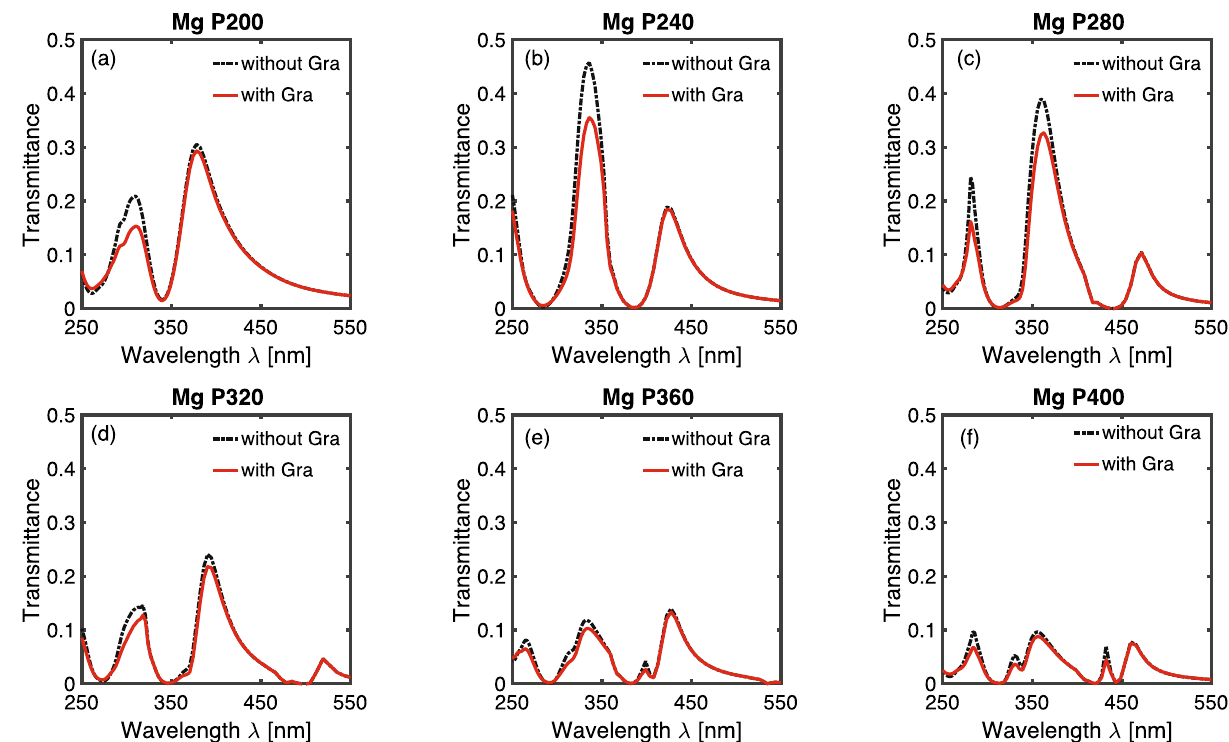
Figure 4. Transmission spectrum of a magnesium hole-array with and without a single-layer intrinsic graphene. The periodicities of the magnesium hole-arrays are ( a ) 200 nm ( b ) 240 nm ( c ) 280 nm ( d ) 320 nm ( e ) 360 nm ( f ) 400 nm. The dashed black curve represents the spectrum for a magnesium hole-array without graphene layer; the solid red line represents the spectrum for a magnesium hole-array with graphene